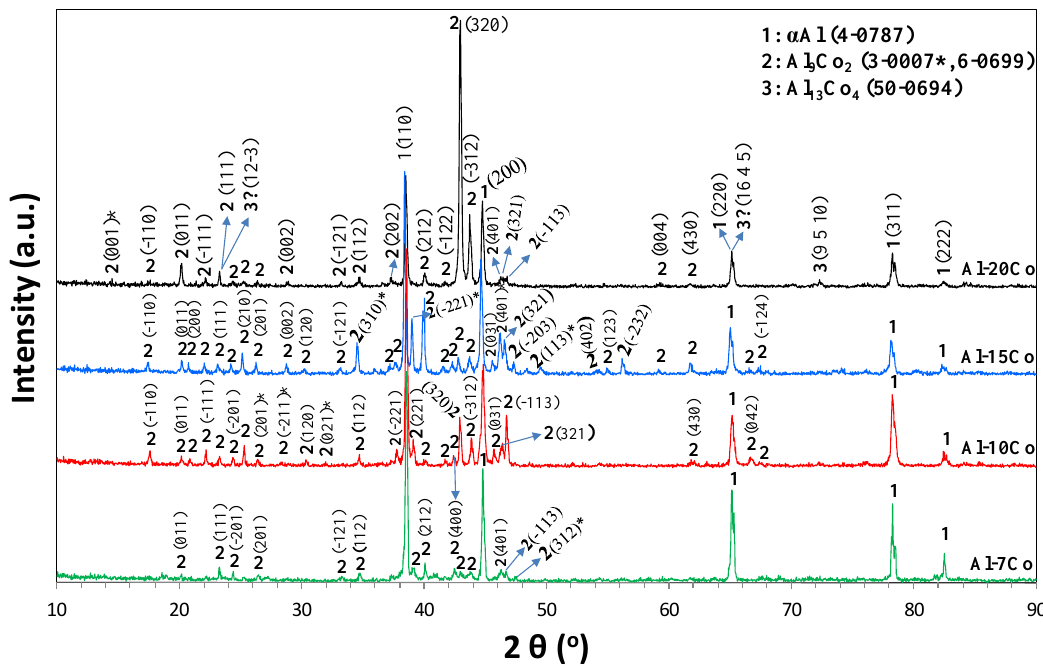
Figure 1. XRD patterns of the Al‐Co alloys (7, 10, 15, 20 wt.% Co).